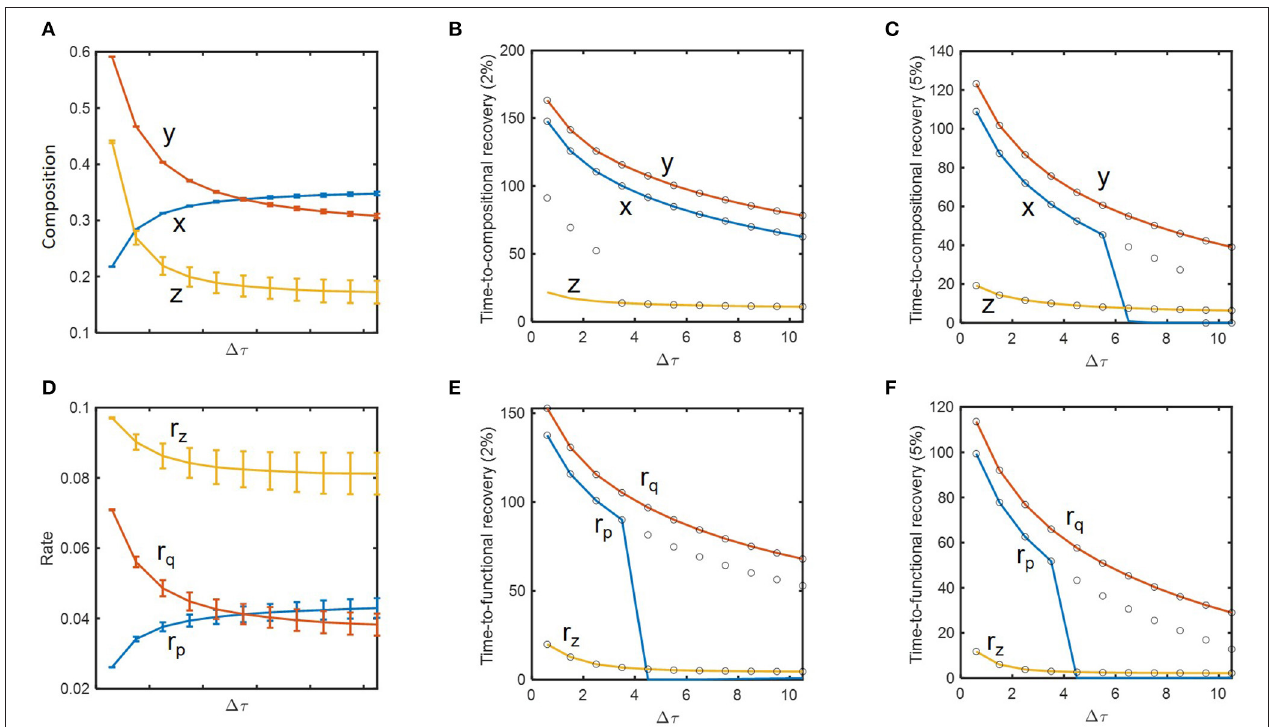
FIGURE 4 | The impact of perturbation interval ( 1τ ) on species abundances, substrate concentration, microbial functions, and their time-to-recoveries: (A) microbial ( x and y ) and chemical compositions ( z ), (B) time-to-compositional recovery calculated by the 2% criterion, (C) time-to-compositional recovery calculated by the 5% criterion, (D) consumption rate of the shared substrate ( r z ) and production rates of distinct products ( r p and r q ), (E) time-to-functional recovery calculated by the 2% criterion, (F) time-to-functional recovery calculated by the 5% criterion. In (B,C,E, and F) , solid lines and open circles denote hitting and settling times,